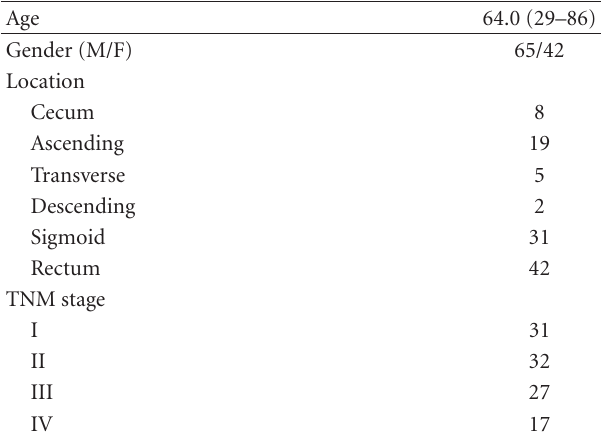
Table 1: Clinical characteristics of clinical CA19-9 negative cases ( n =